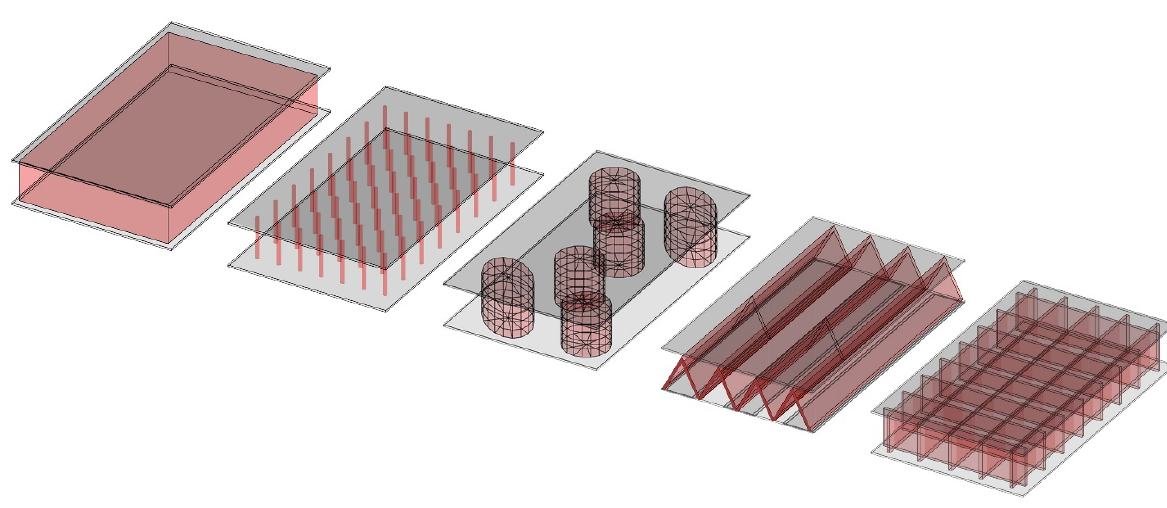
Fig. 3: From left to right: homogenous support, punctual support, regional support, linear support and bi-directional